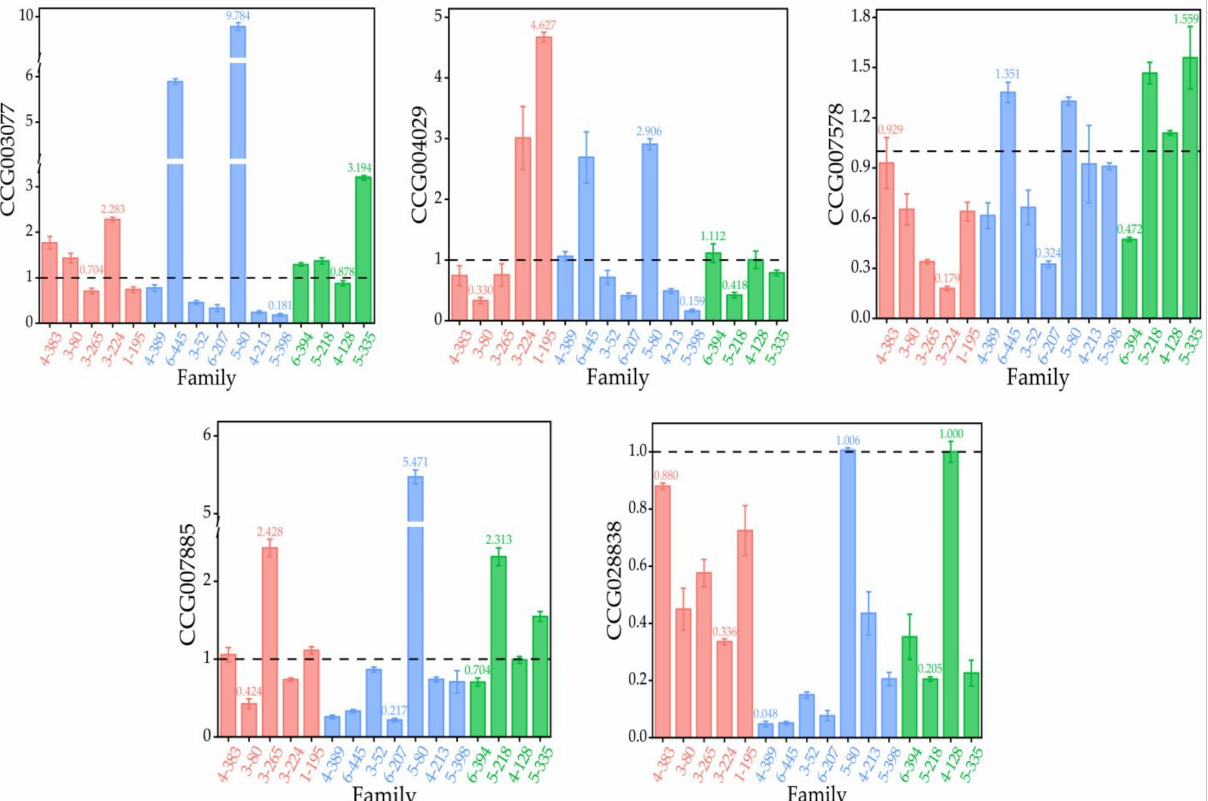
Figure 4. Drought resistance coefficients of relative expression levels of CCG003077, CCG004029, CCG007578, CCG007885, and CCG028838 in all tested families. Red represents drought-resistant families, blue indicates intermediate drought tolerance families, and green represents drought- sensitive families. The number indicates the maximum and minimum values of relative expression levels of CCG003077, CCG004029, CCG007578, CCG007885, and CCG028838 with different drought resistance